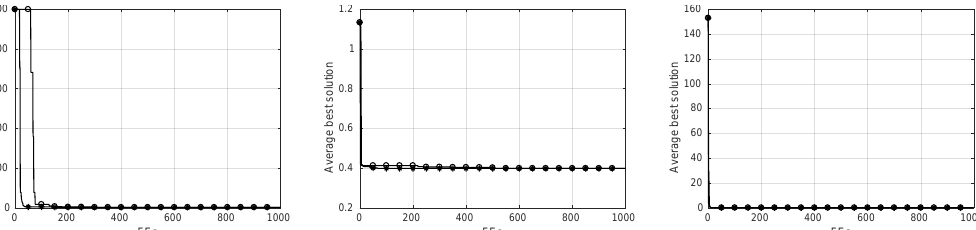
Figure 13. Convergence curves for the benchmark functions f 1 − f 15 in row-major order. Optimization algorithms are SCA [ ◦ ], ESCA [ ∗ ].